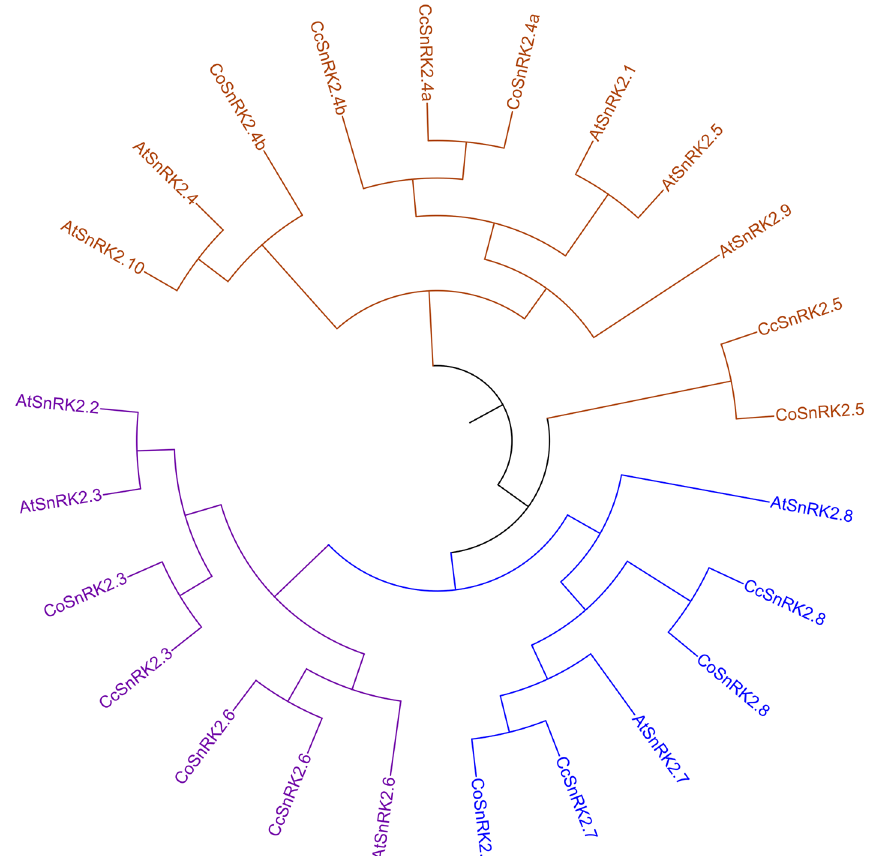
Fig. 2 Phylogenetic relationship among the C. olitorius , C. capsularis , and Arabidopsis thaliana SnRK2 genes. The phylogeny was generated by MEGA7 with maximum likelihood (ML) method and 1000 replicates bootstraps, based on the amino acid sequence of 7, 7, and 10 SnRK2 genes from C. olitorius , C. capsularis , and A. thaliana , respectively. The gene name with purple, blue, and dark red represents SnRK2 groups 1, II, and III,